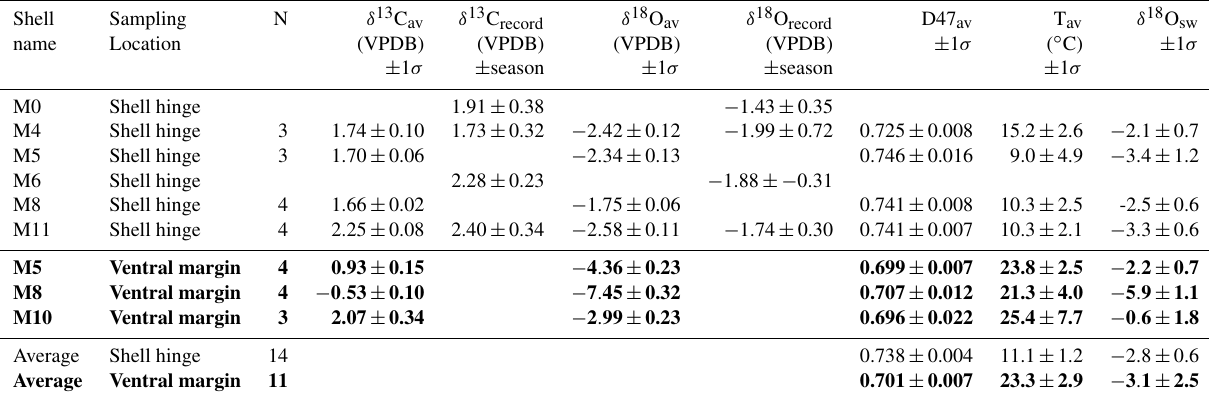
Table 1. Overview table of stable and clumped isotope results in this study. Rows highlighted with bold values samples from the ventral margin of the shells (which contain vesicular calcite). Rows without bold values represent samples of the dense, foliated shell hinge. Note that for some shells (M5 and M8) both the ventral margin and the shell hinge were measured. Columns labelled “ δ 13 C record ” and “ δ 18 O record ” contain averages of the high-resolution stable isotope records measured in the shell hinges (if available, Fig. 5). The bottom two rows contain average (cid:49) 47 and δ 18 O sw values of shell hinge and ventral margin (bold) samples, highlighting the difference between the two sampling